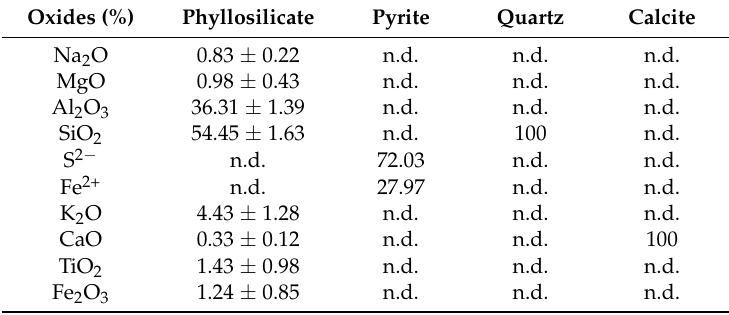
Table 3. Energy dispersive X-ray (EDX) chemical analysis: very fine–grade raw tailings